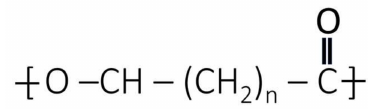
Figure 1. Basic structure of PHA.